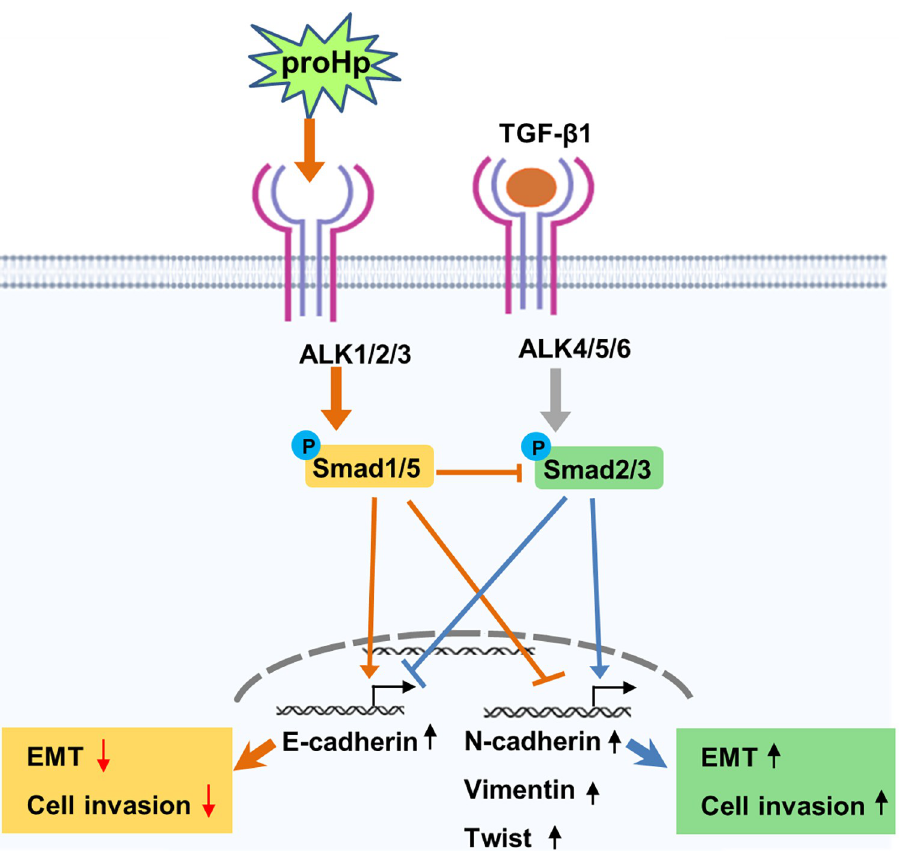
S1 Fig. The effect of Hp2-2 on the gene expression of vimentin and E-cadherin. (TIF) S1 Raw images. Original blot for Figs 1,